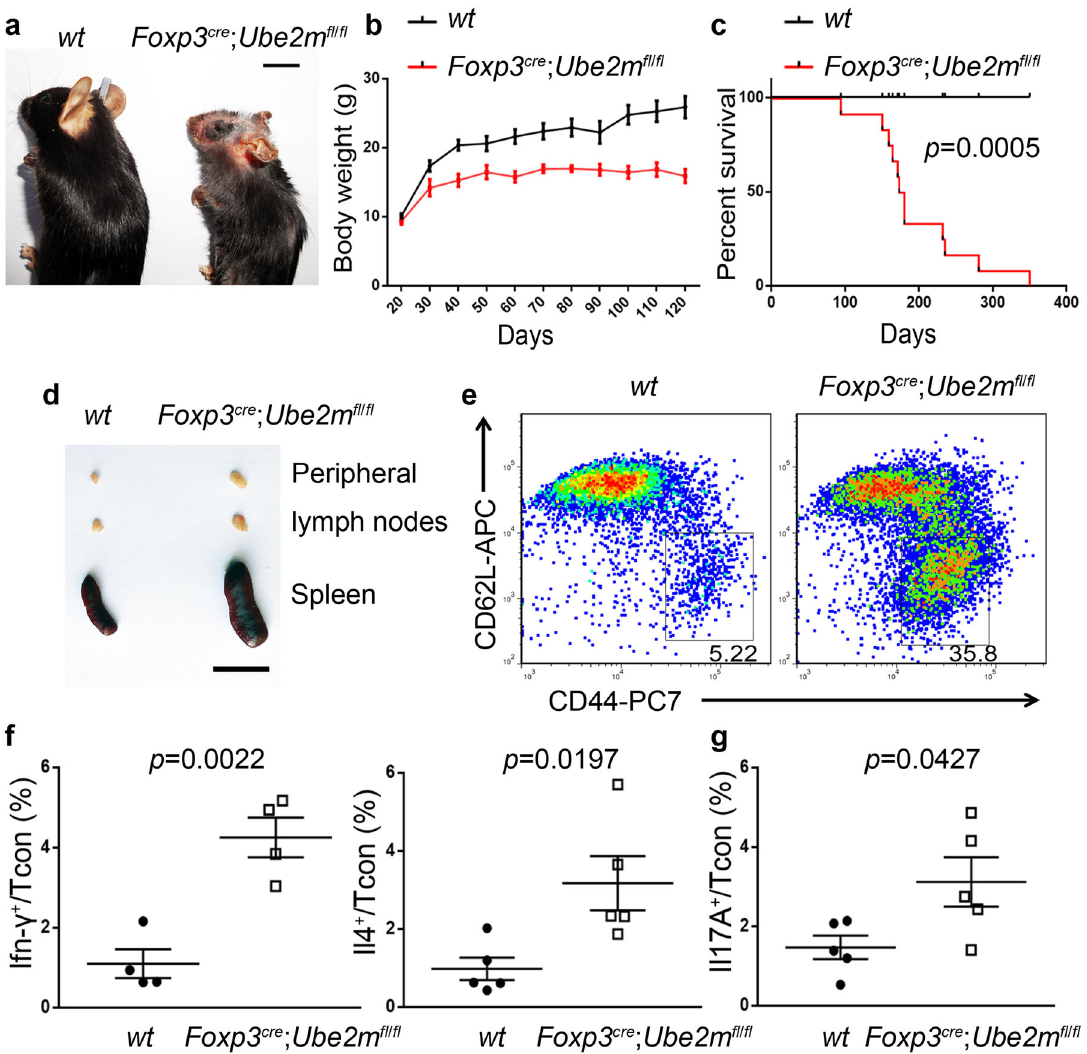
Fig. 7 Fetal, but relative weaker, in fl ammatory disorder in Foxp3 cre ; Ube2m fl / fl mice. a Representative images of wt and Foxp3 cre ; Ube2m fl / fl mice (16 weeks old, male, scale bar = 1 cm). b Gross body weight of wt and Foxp3 cre ; Ube2m fl / fl mice ( n = 20 animals, for gender information see “ source data ” ). c Survival curve of wt and Foxp3 cre ; Ube2m fl / fl mice ( n = 12 animals from both male and female mice; p < 0.0001). d Representative images of the peripheral lymph nodes and spleen from wt and Foxp3 cre ; Ube2m fl / fl mice (16 weeks old, male, scale bar = 1 cm). e Expression of CD44 and CD62L in Tcon cells from peripheral lymph nodes of wt and Foxp3 cre ; Ube2m fl / fl mice (16 weeks old, male). f The levels of Ifn- γ and Il-4 in Tcon cells from peripheral lymph nodes of wt and Foxp3 cre ; Ube2m fl / fl mice (16 weeks old, n = 4 or 5 biologically independent samples respectively from both male and female mice). g The levels of Il- 17A in Tcon cells from peripheral lymph nodes of wt and Foxp3 cre ; Ube2m fl / fl mice (16 weeks old, n = 5 biologically independent samples from both male and female mice). All error bars represent the SEM, data are presented as mean values + / − SEM. The p values were calculated by Mann – Whitney test. Source data are provided as a Source Data fi